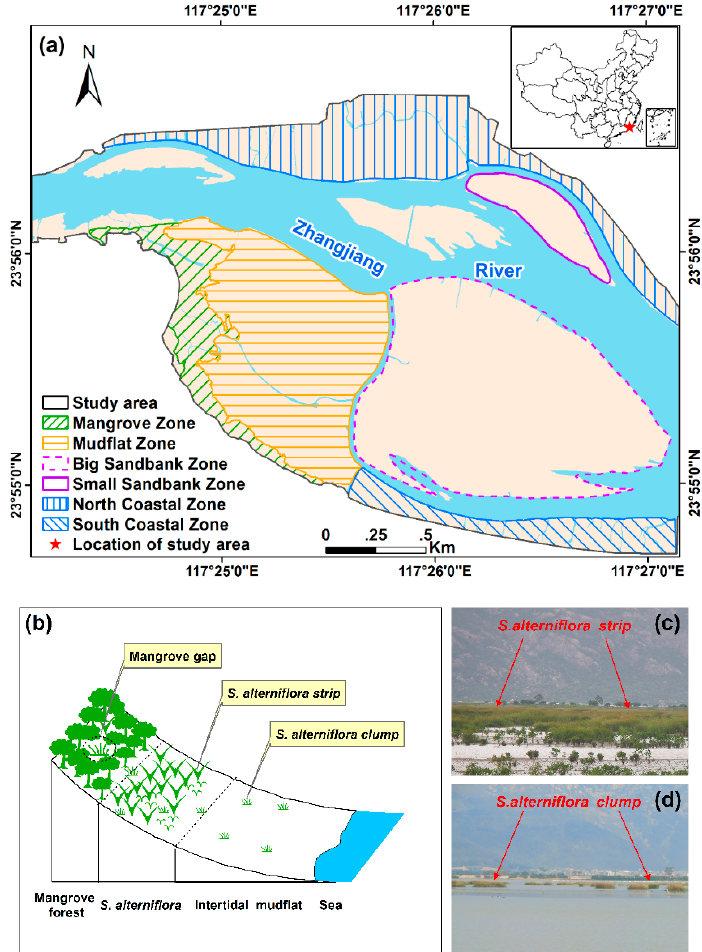
Figure 1. The study area: ( a ) The location of Zhangjiang Estuary in China and the extent of subzones in this area; ( b ) Vegetation distribution of the intertidal zone in the Zhangjiang Estuary; ( c ) Distribution of S. alterniflora populations as a strip along the coast; and ( d ) Expansion of newly colonized S. alterniflora clumps towards the sea.